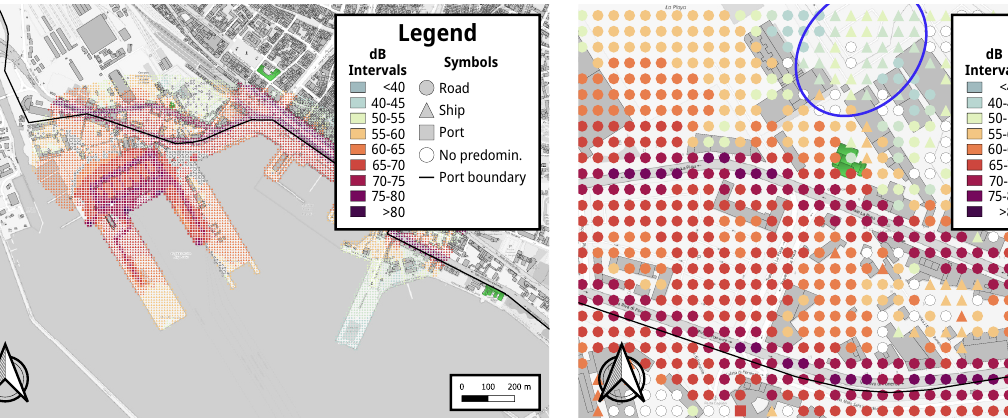
Figure 3: Intensity Noise Source Predominance map of the port of Cagliari for L DEN indicator.